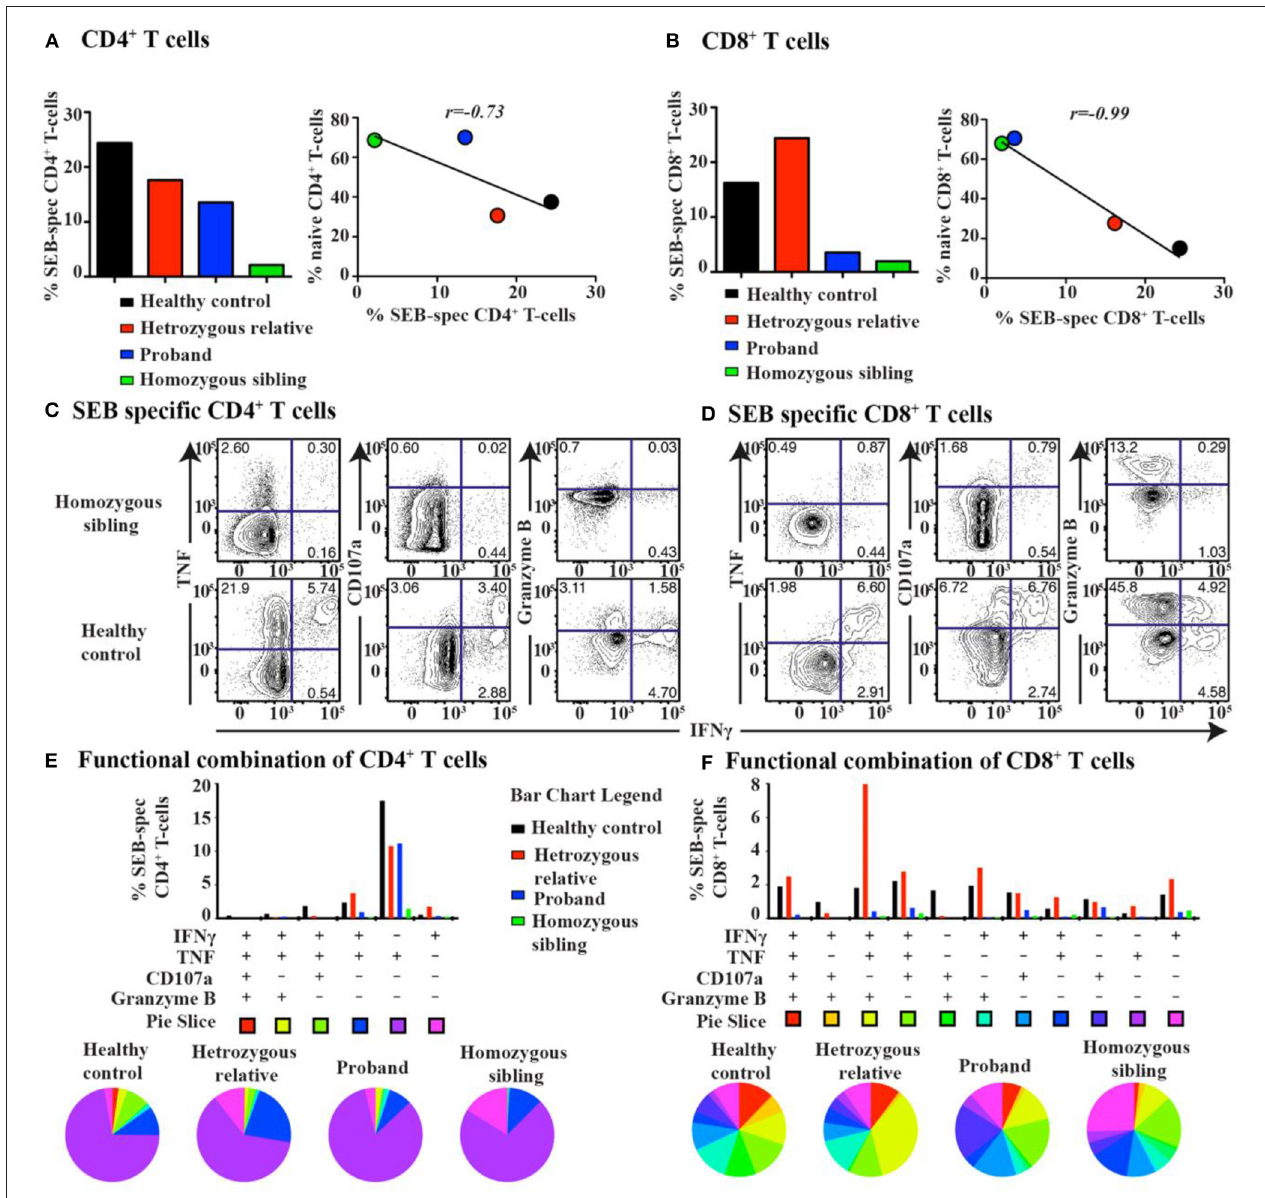
FIGURE 4 | T-cell response and cytokine production after super-antigen simulation in CD70 deficiency. The total frequency of super-antigen (SEB)-specific (A) CD4 + and (B) CD8 + T cells (left). Pearson correlation analysis between the frequency of SEB-specific T cells and naive T cells for all subjects (right). Representative biaxial plots of SEB-specific (C) CD4 + and (D) CD8 + T-cell expression of IFN γ together with TNF, CD107a, or granzyme B for a homozygous patient and a healthy control. Corresponding SPICE analysis of all functional combinations (based on Boolean gating) for each patient’s SEB-specific (E) CD4 + and (F) CD8 + T-cell response (below). Functional combinations with no detectable response ( < 0.05%) are not depicted in the graph.